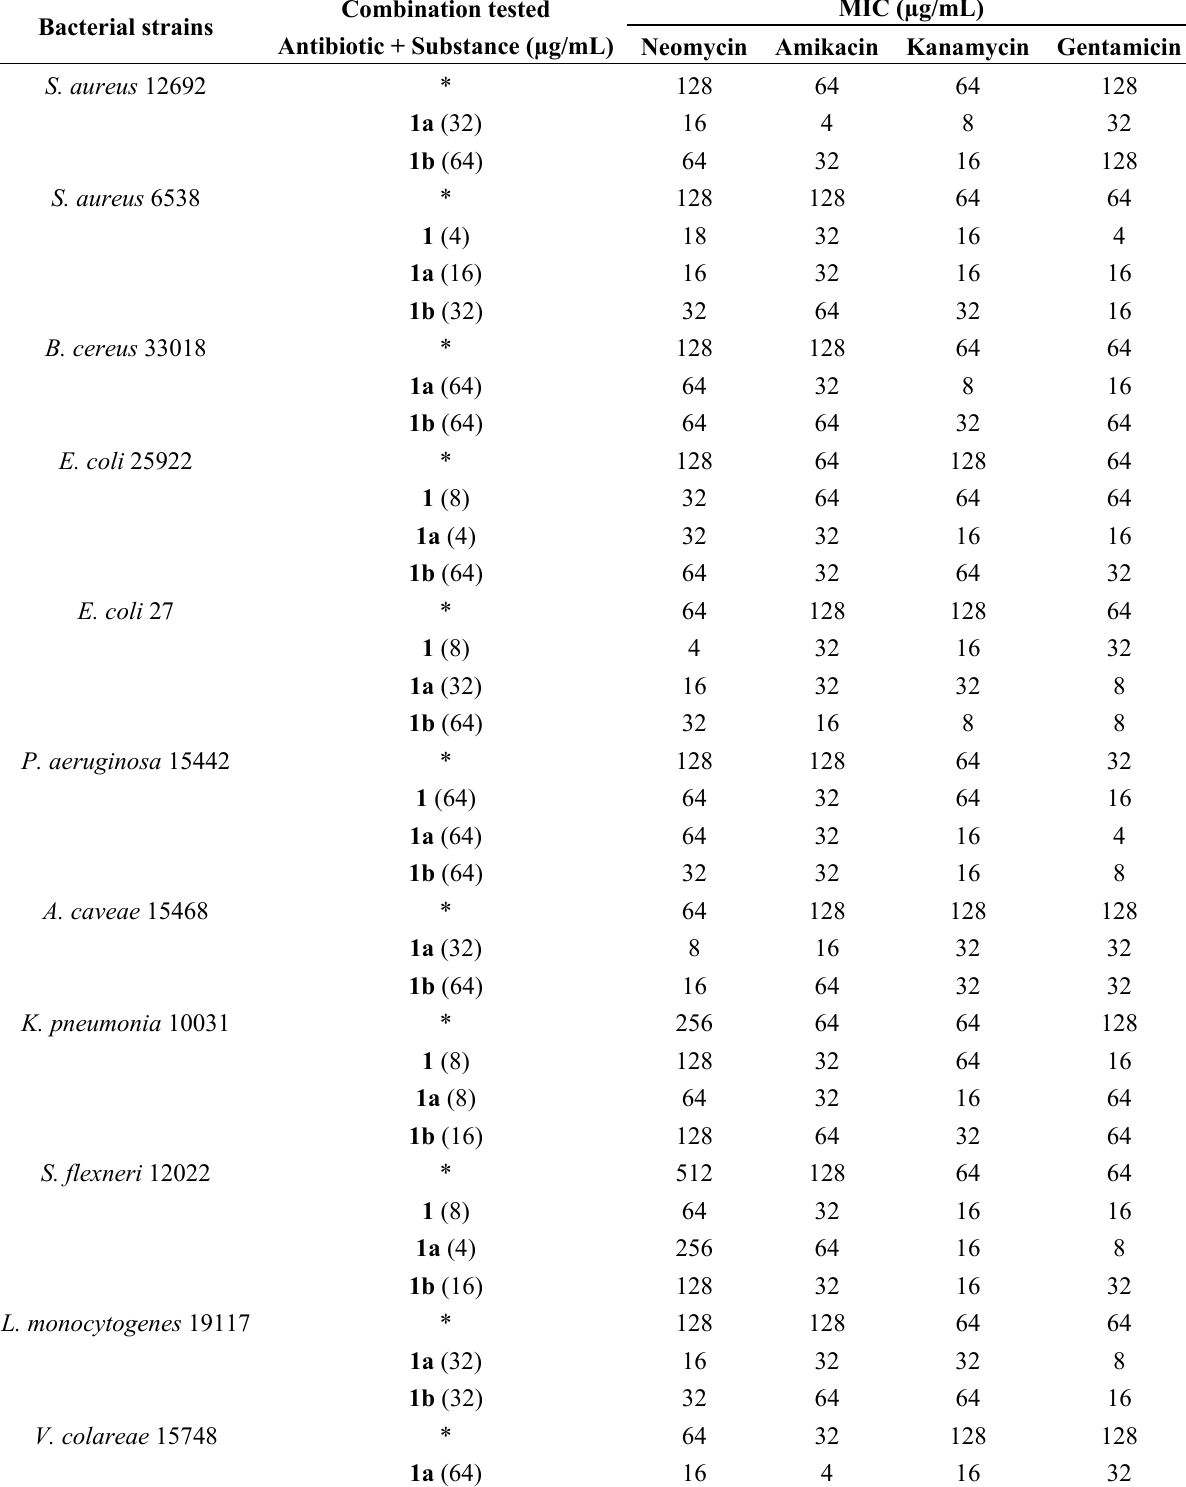
Table 2. Combinating testing of ursolic acid ( 1 ), 3 β -acetoxy-urs-12-en-28-oic acid ( 1a ) and 3 β -formiloxy-urs-12-en-28-oic acid ( 1b ) plus neomycin, amikacin, kanamycin and gentamicin against bacterial